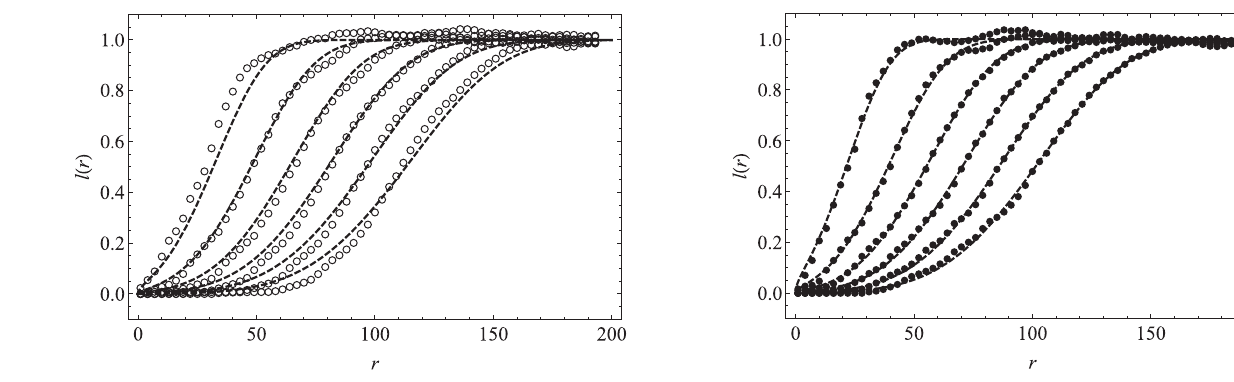
FIG. 16. Dashed lines show theoretical shape of Séguy ’ s curve Eq. (32) centered at peak of population density ρ ¼ e − r=R with R ¼ 20 . Curve computed using Eq. (32) when β ¼ 1 . 4 , σ ¼ 5 , times are t ¼ 10 , 20, 30 with offset t 0 ¼ − 5 . 77 (maximum likelihood estimate). Simulation points give equivalent correla- tions in the full model computed from 100 independent simu- lations in a 400 × 400 system.